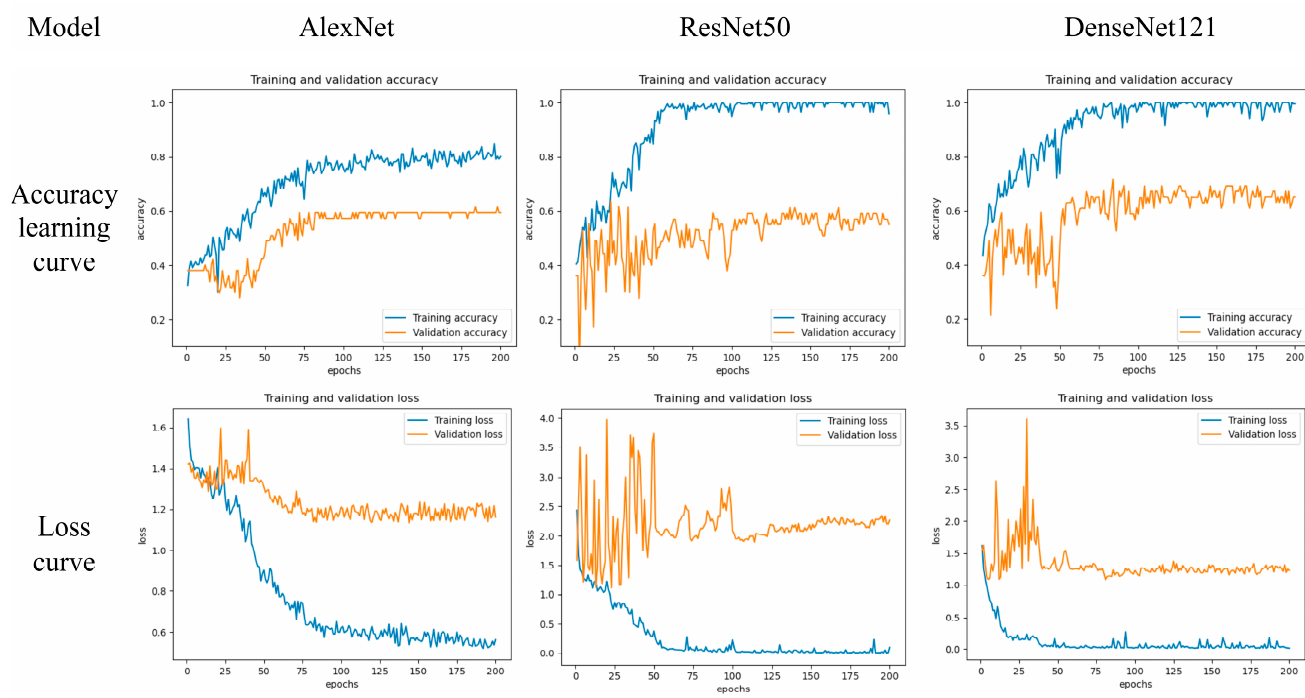
Figure 7. Accuracy and loss learning curve for the representative CNNs, includes AlexNet, ResNet50, and DenseNet121.